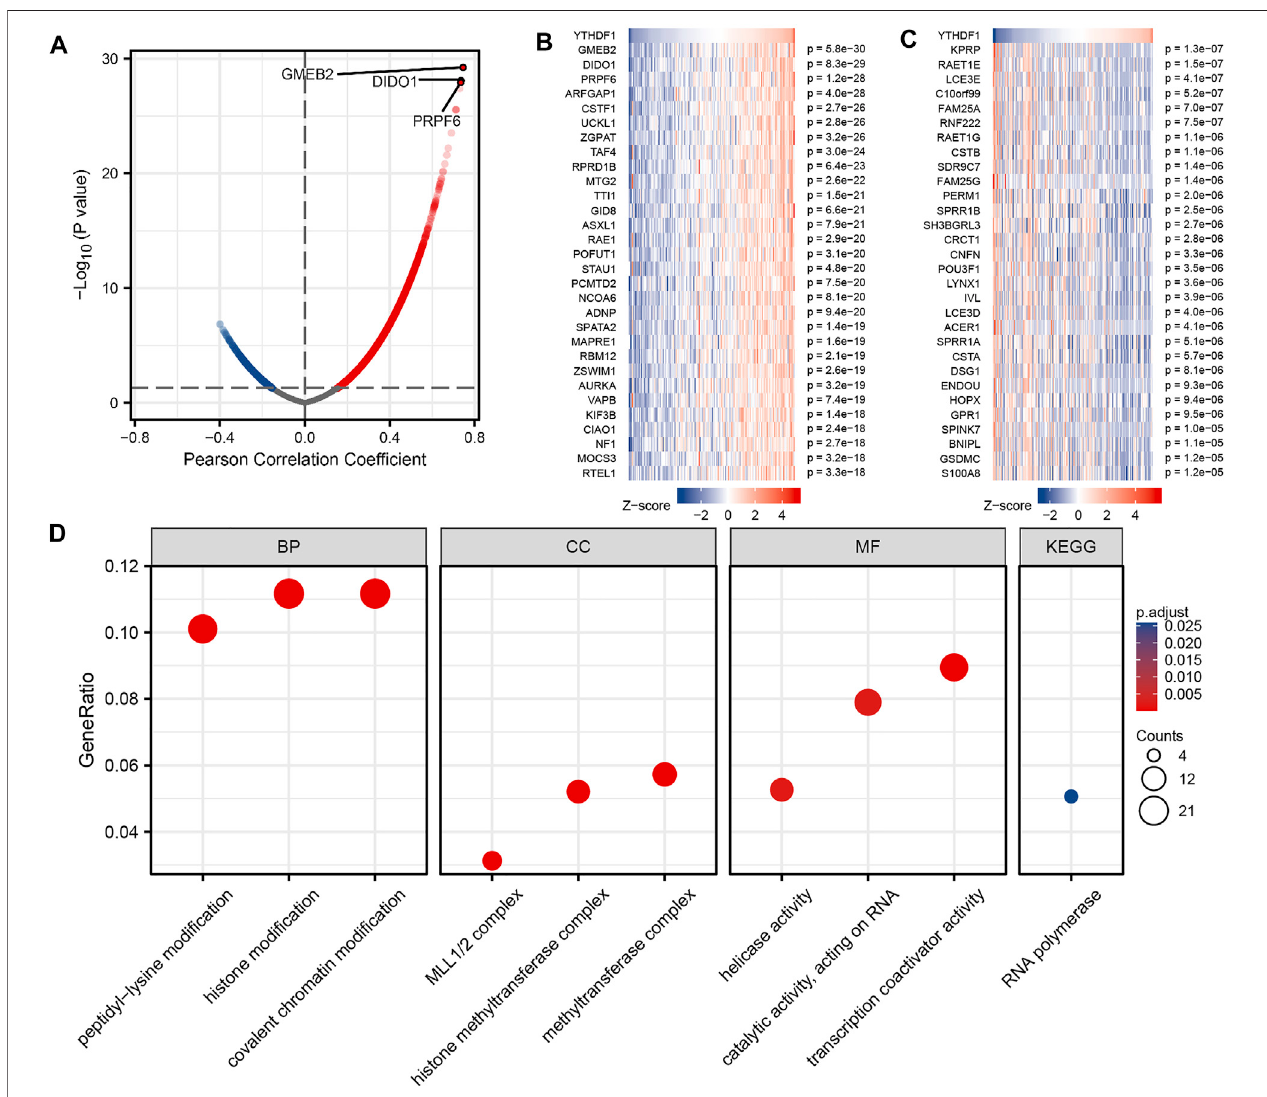
FIGURE4| EnrichmentanalysisofYTHDF1genecoexpressionnetworkinesophagealcarcinoma(ESCA). (A) Volcanomapindicatedcoexpressiongenescorrelatedwiththe expressionlevelofYTHDF1inTCGAESCAcohort. (B,C) Heatmapsindicatedthetop30coexpressiongenespositivelyandnegativelyassociatedwithexpressionlevelofYTHDF1 in the TCGA ESCA cohort. (D) Enrichment analysis of Gene Ontology term and Kyoto Encyclopedia of Genes and Genomes (KEGG) pathway for YTHDF1 coexpression genes.